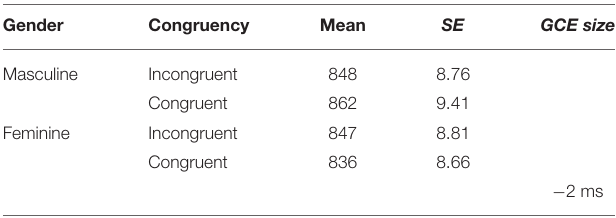
Gender, factor “Target gender,” Congruency, factor “Gender congruency.” Formula of the final model: − 1000/RT ∼ congruency * gender + animacy + (congruency | participant) + (congruency |